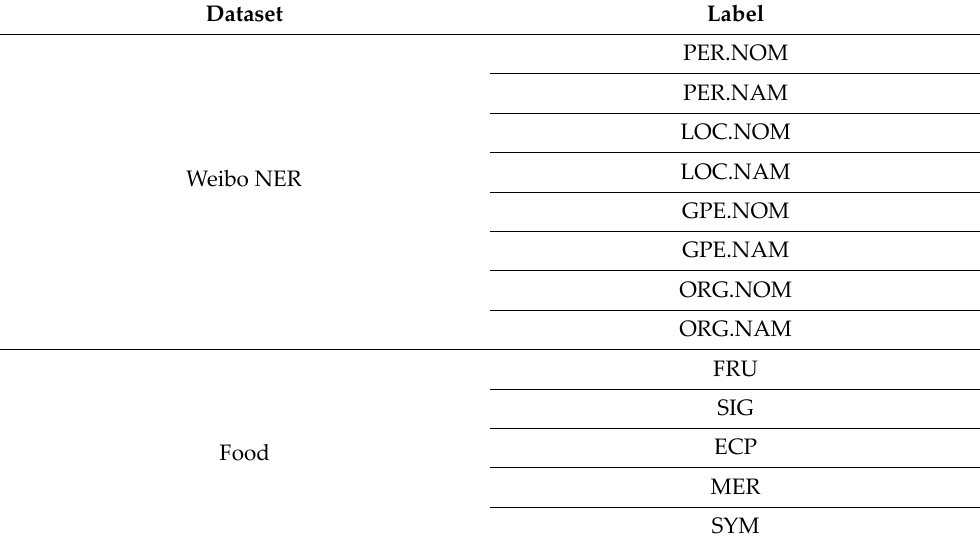
Table 2. Dataset label